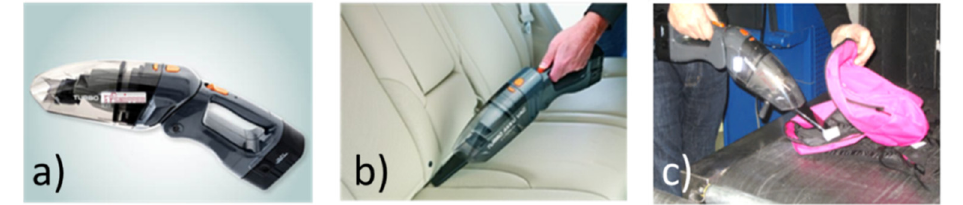
Figure 23. ( a ) ESP sampler system built into a commercial, battery ‐ operated vacuum cleaner. Explosives particles and/or illicit drug residue were extracted from purposely contaminated environments ( b , c ) and placed onto cotton swabs inserted into the ESP sampler. Solid ‐ vapor conversion and detection still needs to be performed by a separate stationary detector system.